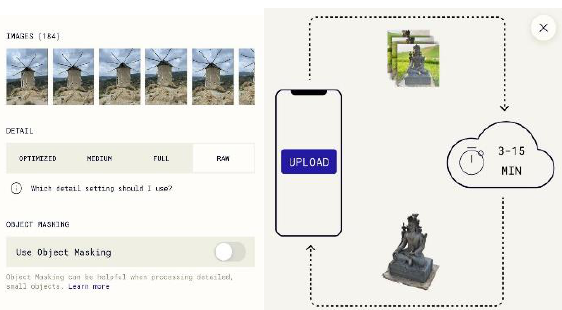
Figure 6. Cloud processing of the images via Polycam